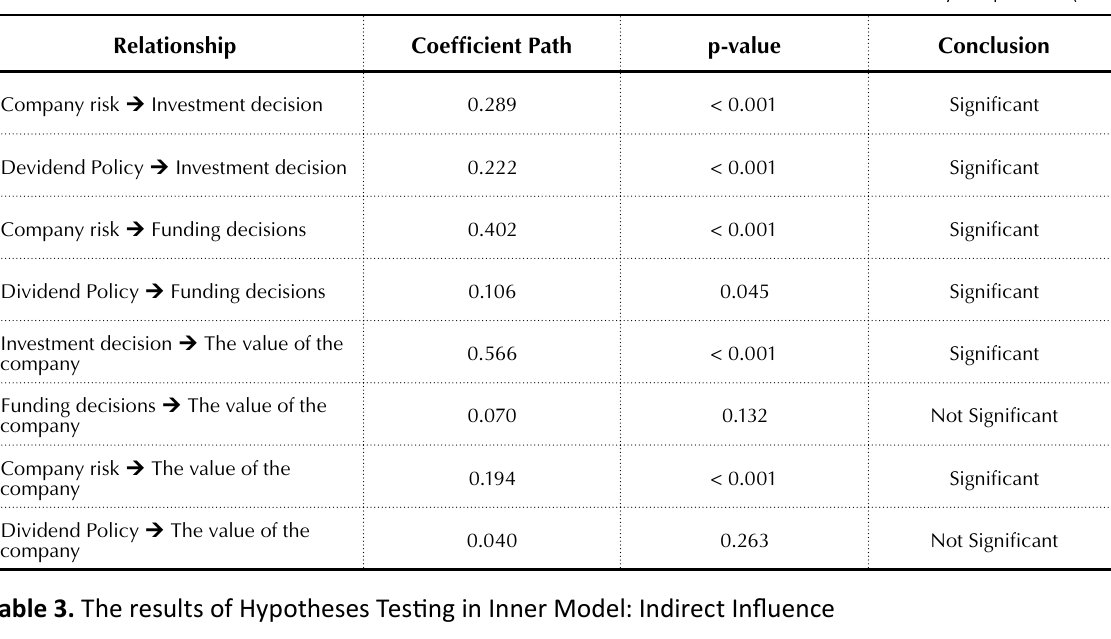
Table 2. Hypotheses Testing Model WarpPLS